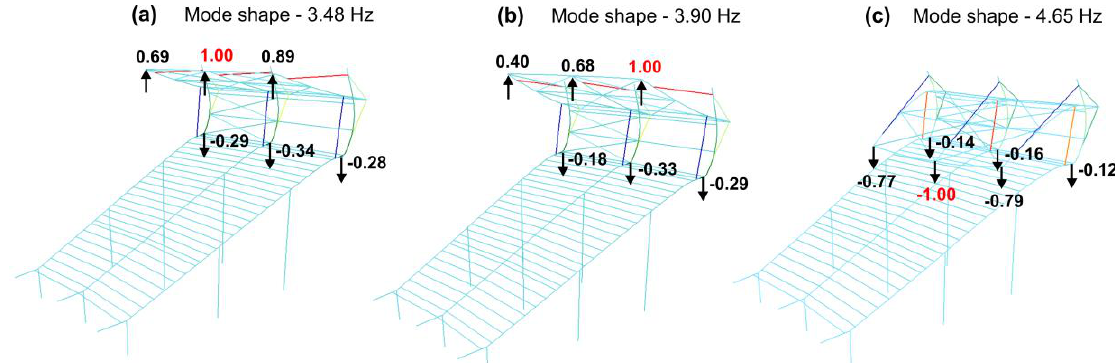
Figure 18. Mode shapes and frequencies of natural vibrations of a single stand section obtained from numerical simulations: ( a ) 3.48 Hz, ( b ) 3.90 Hz, ( c ) 4.65 Hz.